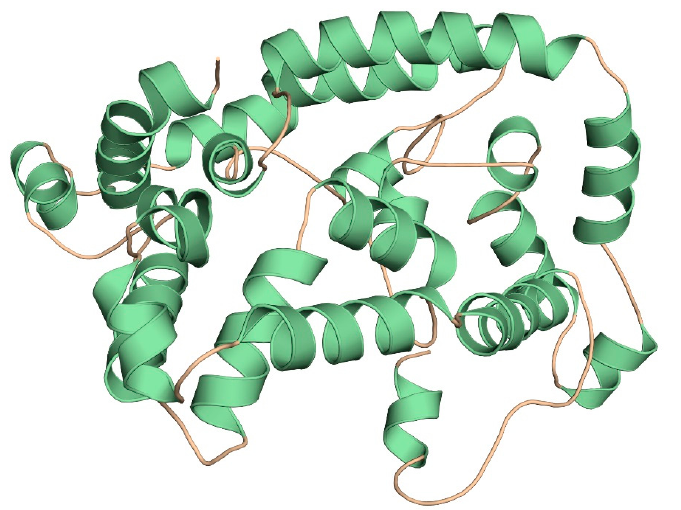
Figure 4. Homology modelling of the three-dimensional structure of the final multi-epitope vaccine construct.